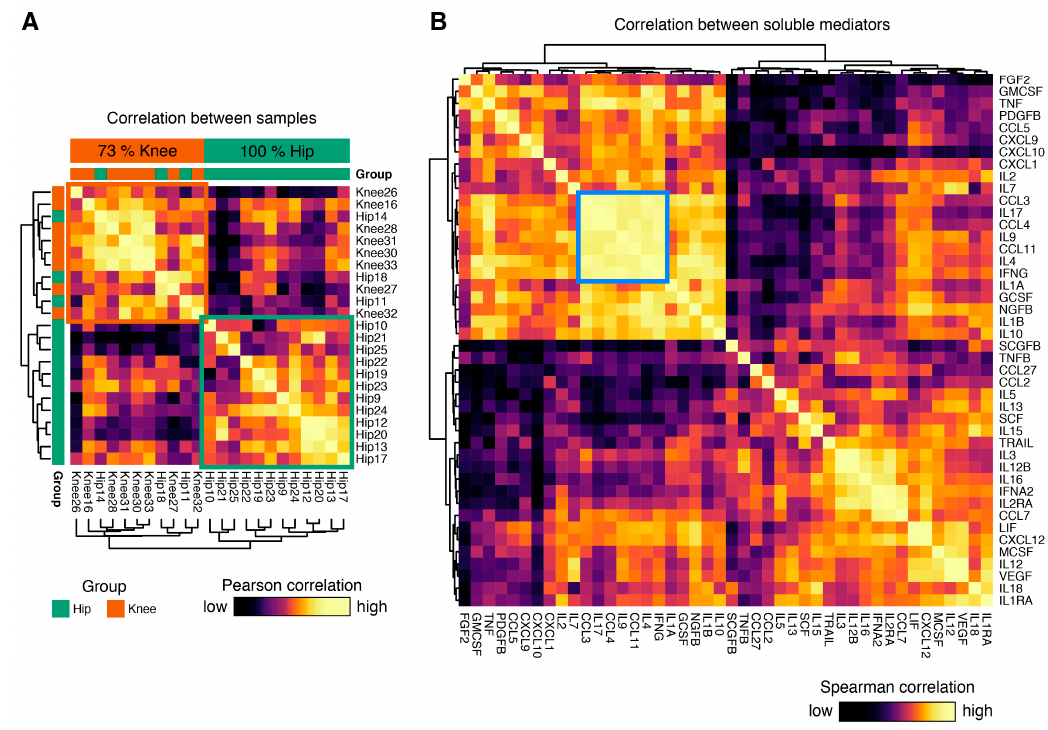
Figure 2. Visualization of the correlation matrix between samples and soluble mediators. ( A ) Heatmap showing the clustered Pearson correlation between all sample-sample pairs based on expression of all cytokines. This unsupervised approach revealed two major groups of samples, one exclusively consisting of hip OA samples (12/12, 100%), and one predominantly of knee OA samples (8/11, 73%). ( B ) Heatmap showing the spearman rank correlation between all cytokine-cytokine pairs. One highly correlated cluster of cytokines consisting of IFNG, IL4, CCL11, IL9, CCL4, IL17, and CCL3 was identified.